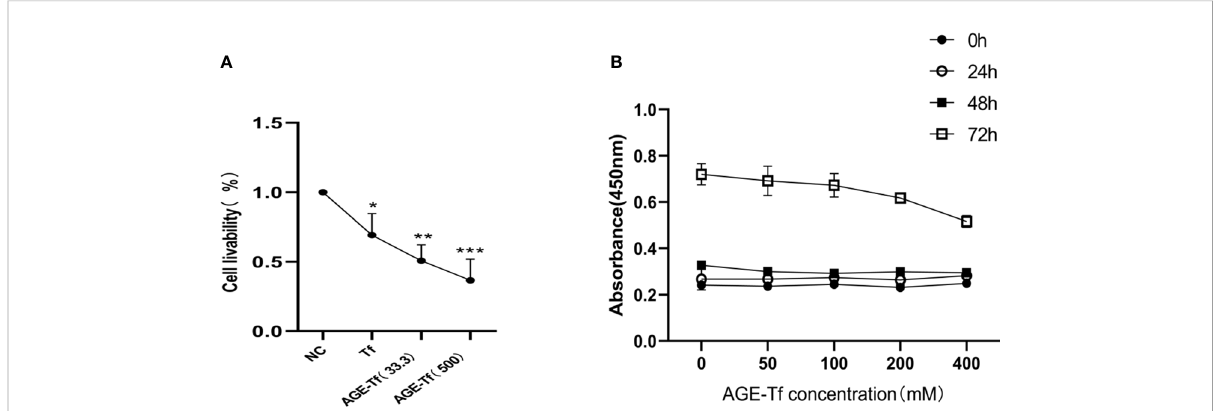
FIGURE 3 Effect of AGE-Tf on HK-2 cell viability. (A) Effect of Tf glycation on survival rate of HK-2. (B) Survival of HK-2 cells under different AGE-Tf concentrations and time points. Compared with the NC group, *p < 0.05, **p < 0.01, ***p < 0.001; AGE-Tf (33.3): the glucose concentration was 33.3 mM when preparing AGE-Tf; AGE-Tf (500): the glucose concentration was 500 mM when preparing